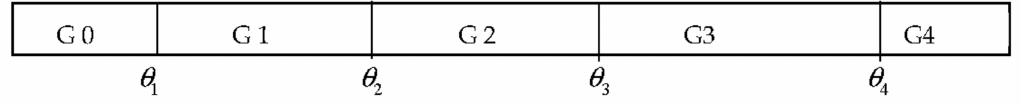
Figure 1. The threshold division of cotton aphid